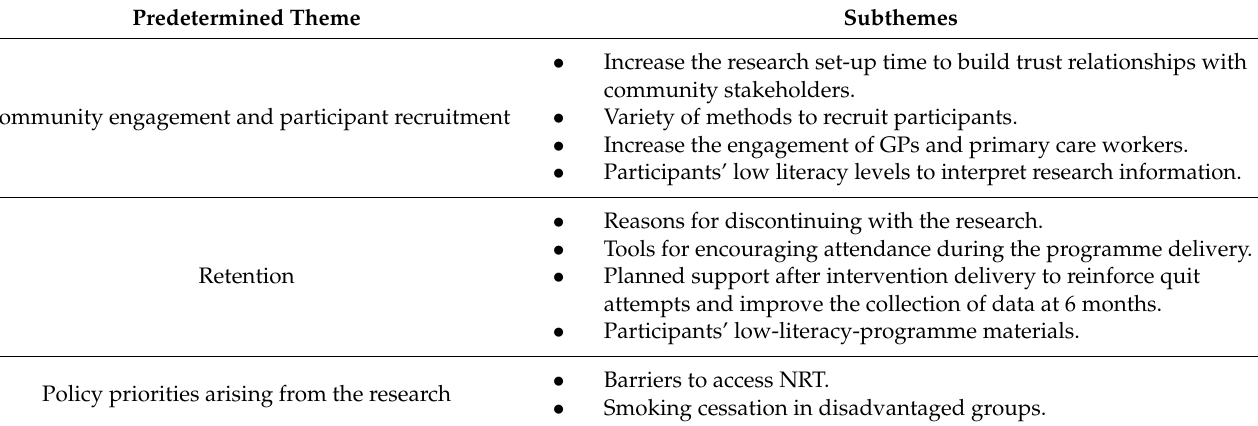
Table 2. Themes and subthemes from field notes and questionnaire